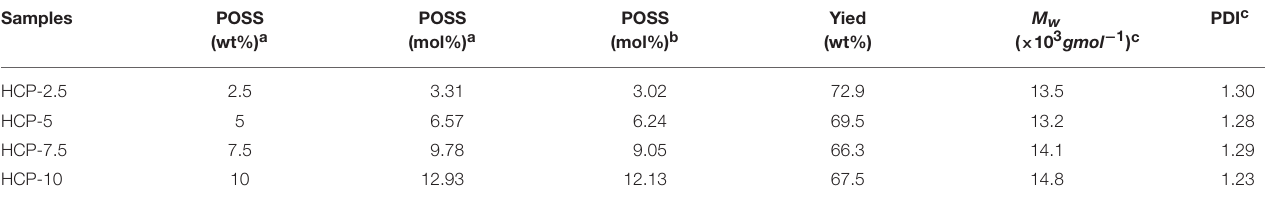
TABLE 1 | Synthesis results of HCPs with different POSS contents.